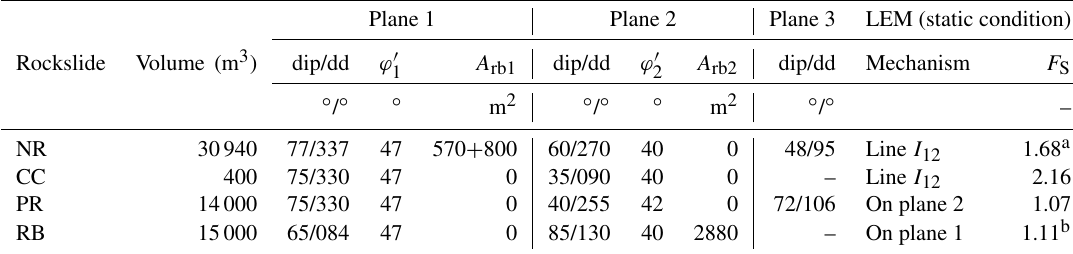
Table 3. Input parameters for the static LEM stability analyses after Forte et al.